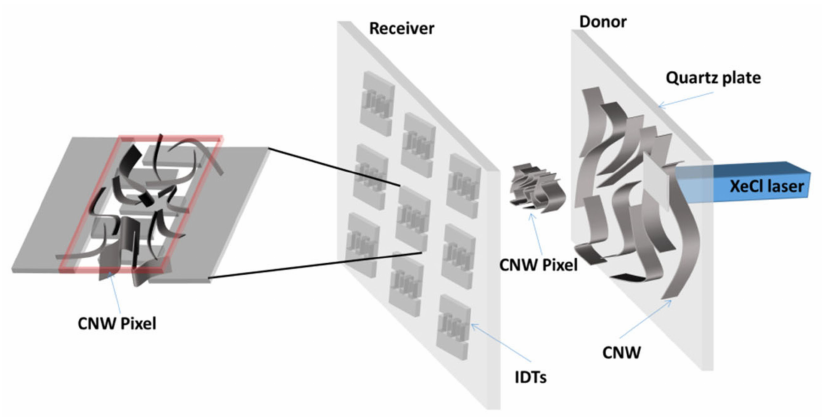
Figure 1. Sketch of the LIFT setup showing the transfer of the CNW donor material onto the receiver substrate (polyimide foil with pre-patterned Pt electrodes). The donor and receiver are placed onto an xyz translation stage. The laser beam impinges through the transparent quartz plate and pushes forward a small portion of the CNW film onto the polyimide foil with pre-patterned Pt